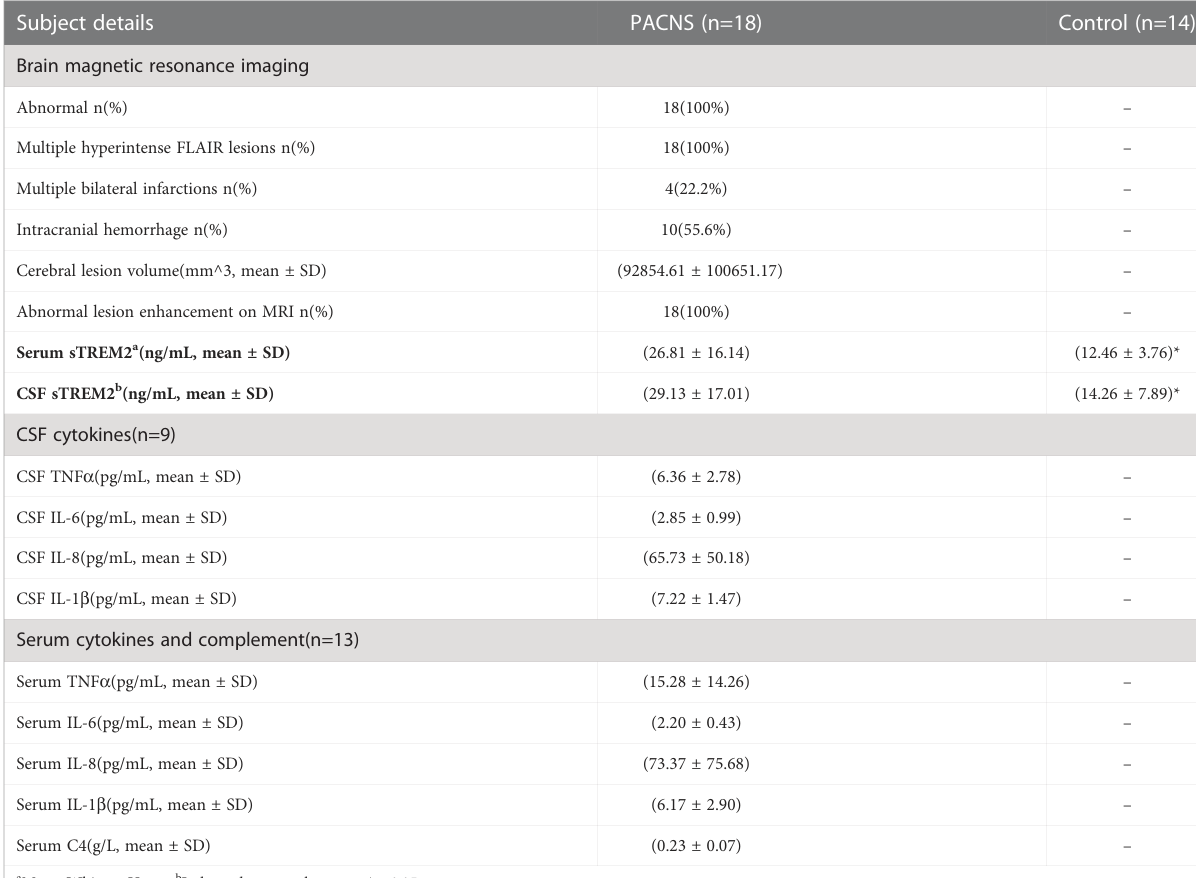
TABLE 2 Imaging data and sTREM2 and in fl ammatory factors levels of patients in the PACNS and control